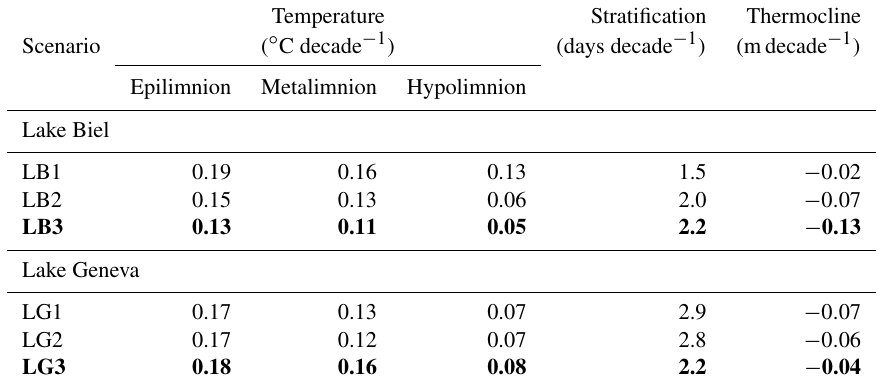
Table 5. Change in temperature, length of the stratified period and depth of the thermocline (negative values correspond to a shallower thermocline) for each scenario listed in Table 4. Estimates given as mean of the daily difference between the reference period and the far-future time period. Temperature anomalies are volume-weighted and vertically averaged. Most likely scenarios are shown in bold.